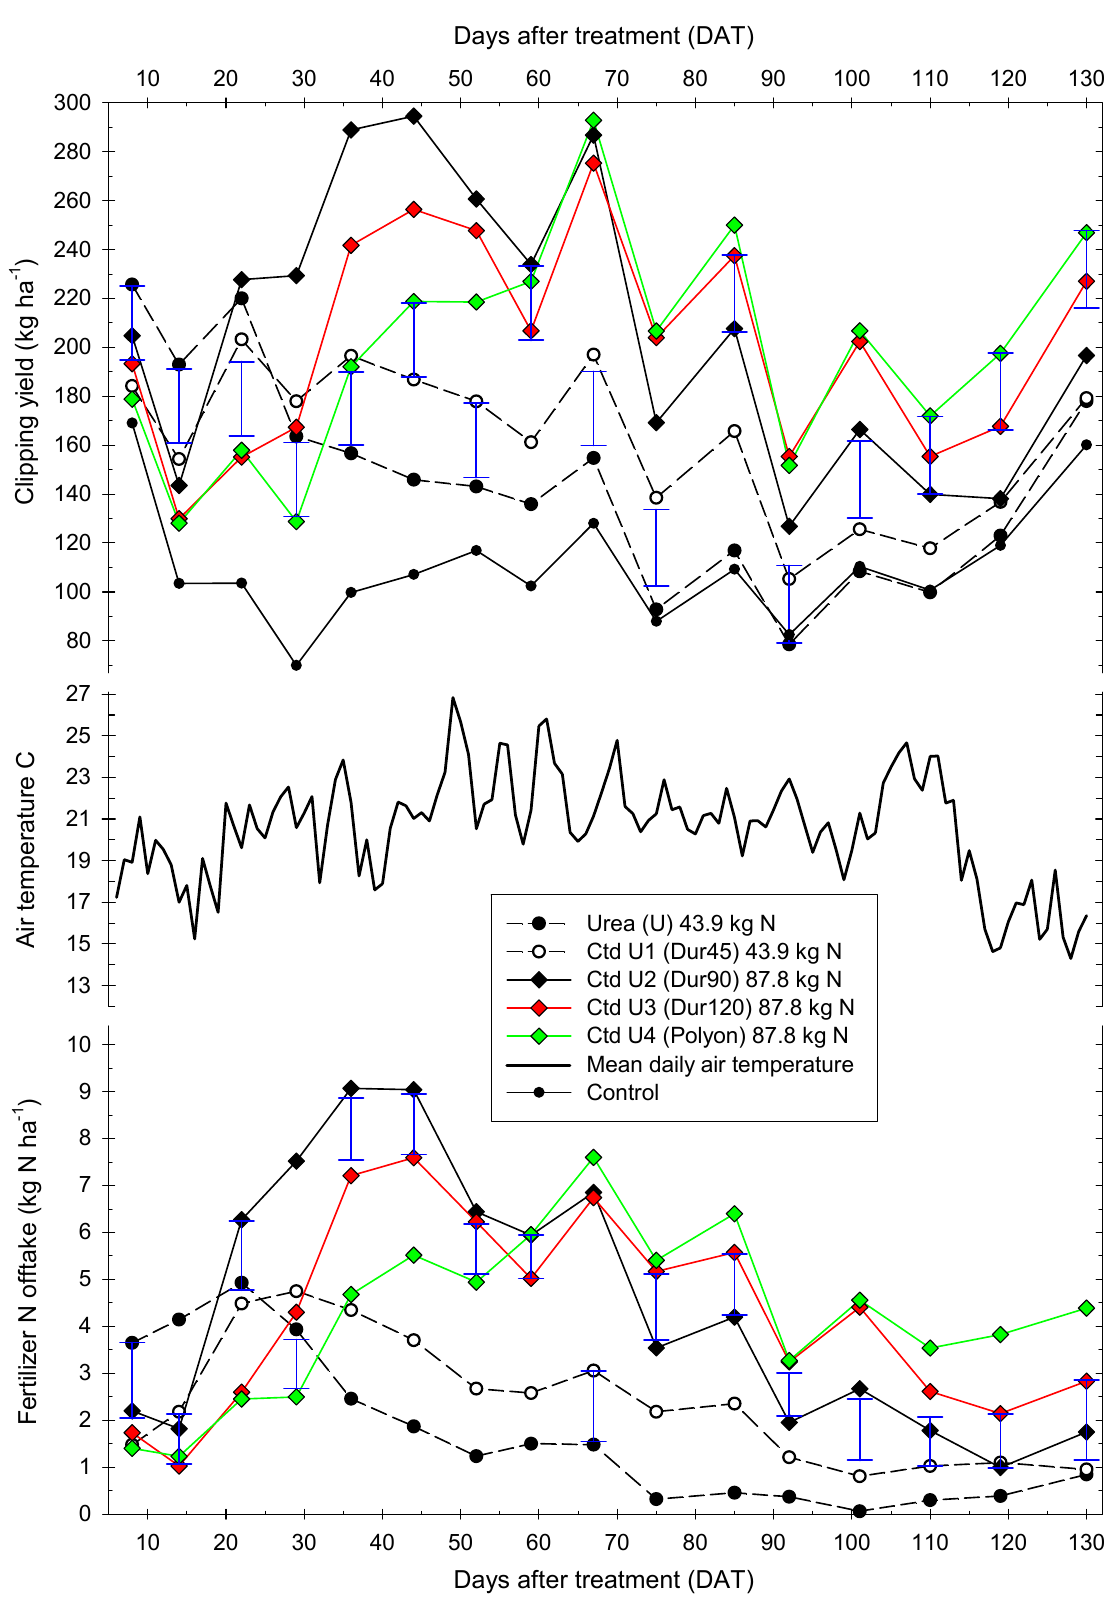
Figure 1. Kentucky bluegrass clipping yield and fertilizer N offtake (ha − 1 ) by fertilizer treatment and mean daily air temperature, all by days after treatment (DAT). Blue error bar lengths denote Fisher’s Protected Least Significant Difference (LSD) at a 0.05 alpha level.